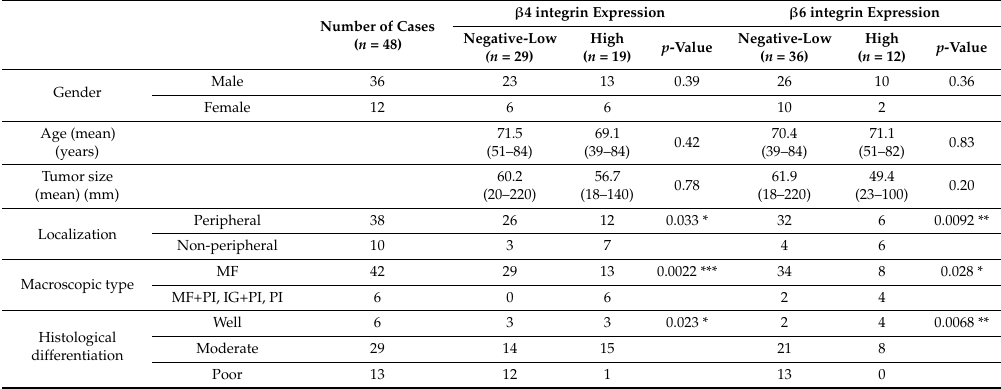
Table 1. Correlation between β 4 and β 6 expressions and clinicopathological characteristics in intrahepatic